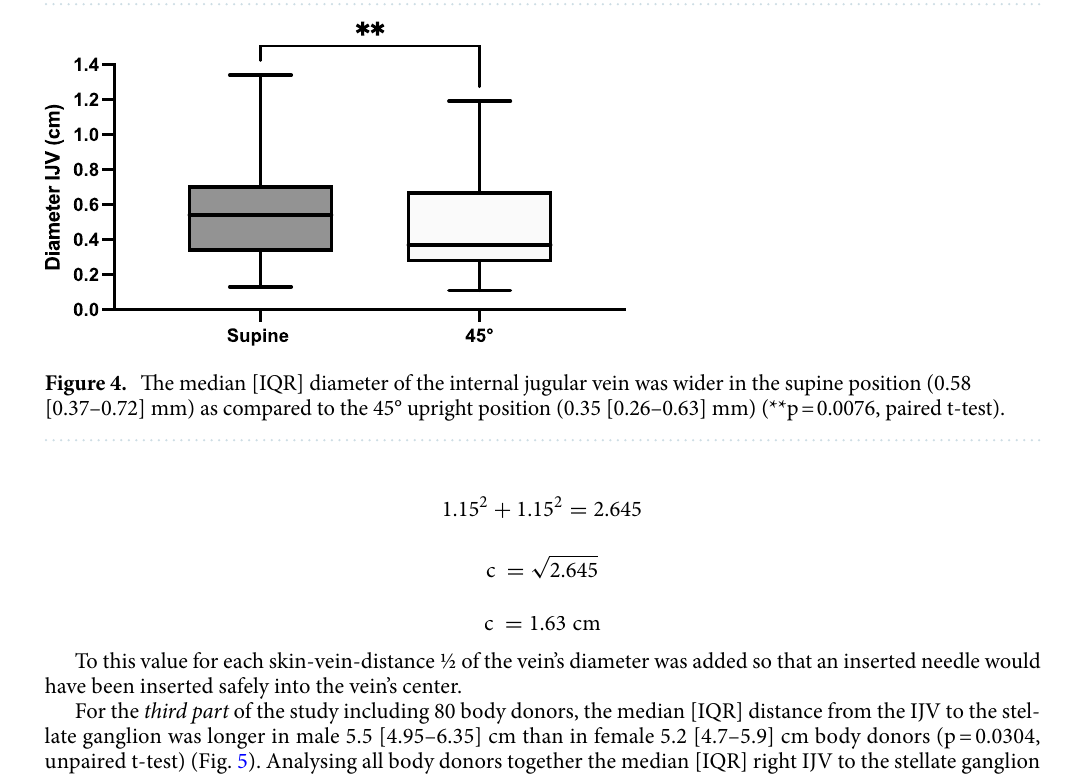
Figure 3. ( A – D ) Distance between skin and the internal jugular vein correlated with the BMI at the right and left side with an 45° angle of the upper body (Pearson r of 0.66 ( A ) and 0.638 ( B ) respectively; p < 0.0001) as well as on the right and left side in supine position (Pearson r of 0.6369 ( C ) and 0.71 ( D ) respectively; p < 0.0001).